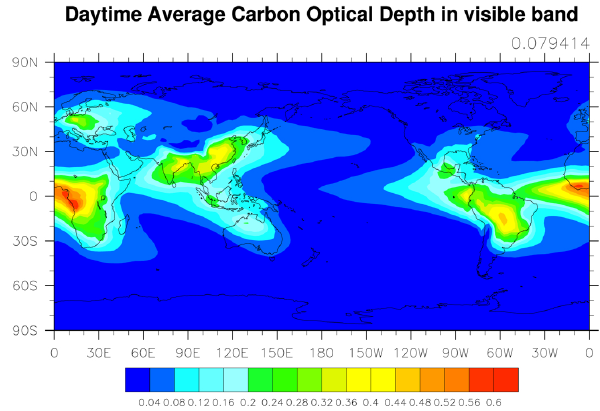
Fig. 1. Global distribution of carbonaceous aerosol optical depth. The mass of carbonaceous aerosols is increased by a factor of 3 as compared to the baseline mass in CAM3.5 to better represent atmo- spheric carbonaceous aerosols heating found from the